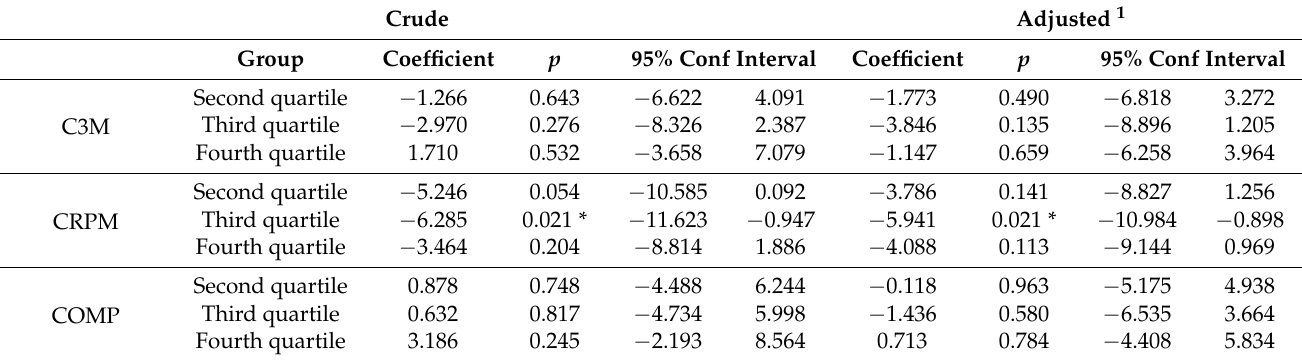
Table 4). After adjusting for age and BMI, associations between the third C3M quartile